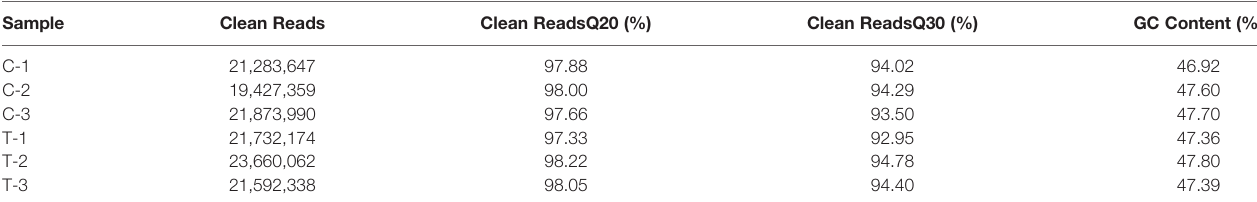
TABLE 2 | Summary of transcriptome sequencing data of liver in pompano.